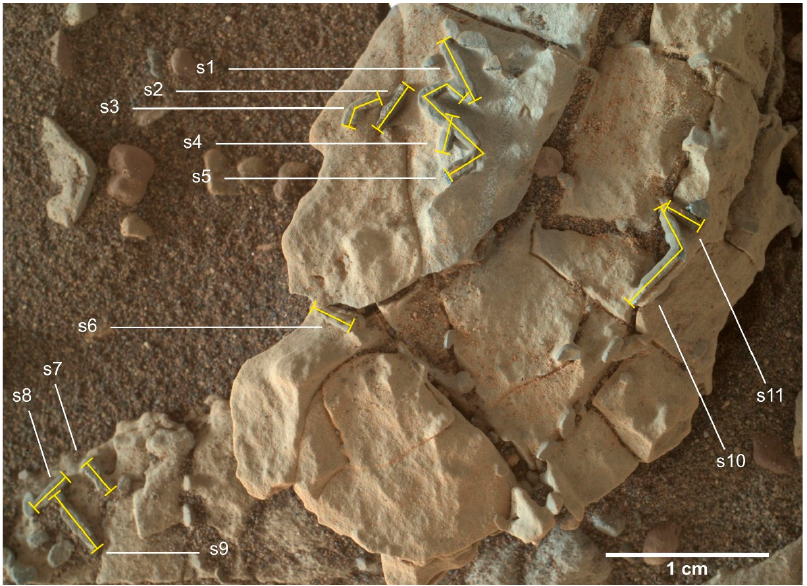
Figure A2. Length analysis map.